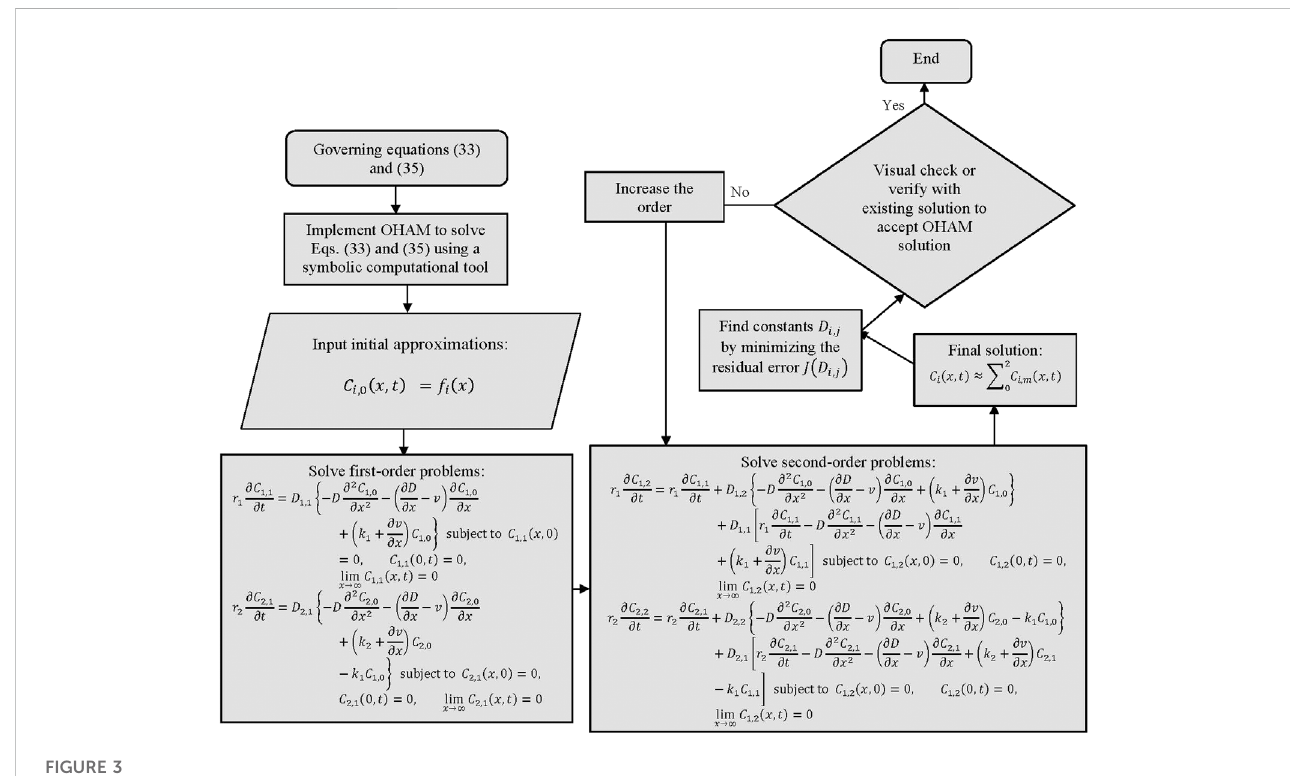
FIGURE 3 Flowchart for the OHAM solution (65).